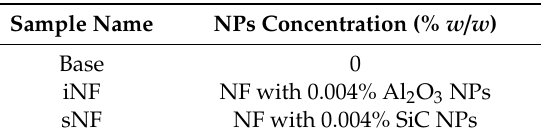
Table 2. Details of nanofluids studied in this